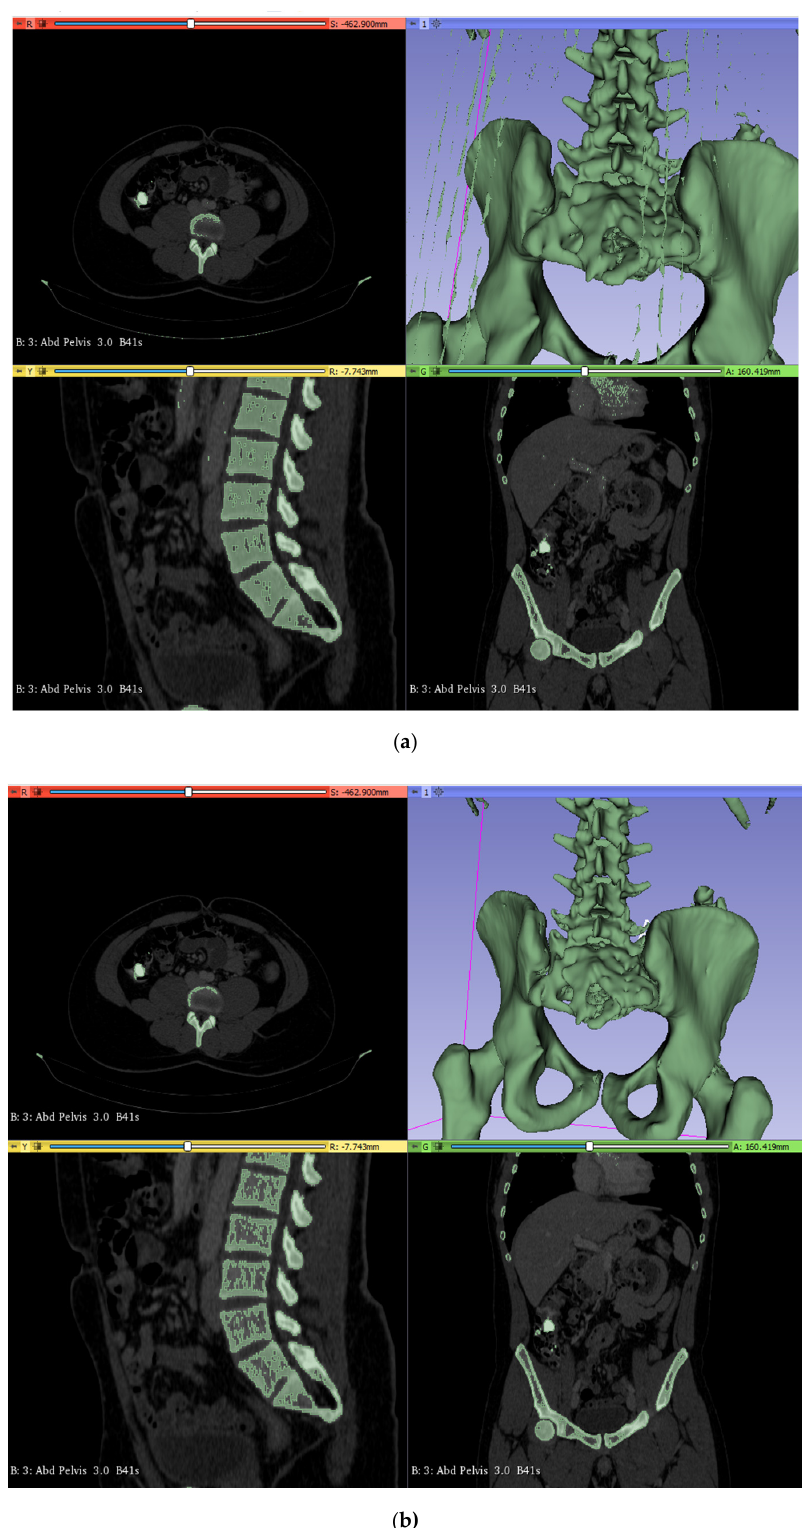
Figure 1. ( a ) Segmentation A, including the lower densities. ( b ) Segmentation B, focusing on the higher densities. Three-dimensional CAD volumes creation directly from the medical images stored in DICOM format and thanks to the use of 3D Slicer [13,14] open-source software.